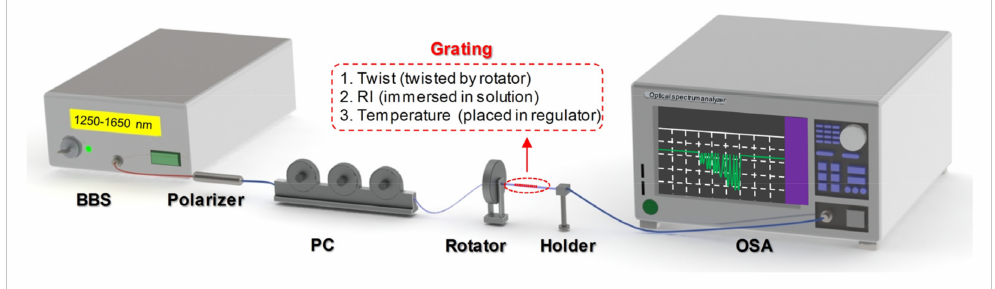
Figure 5. Setup scheme for sensing